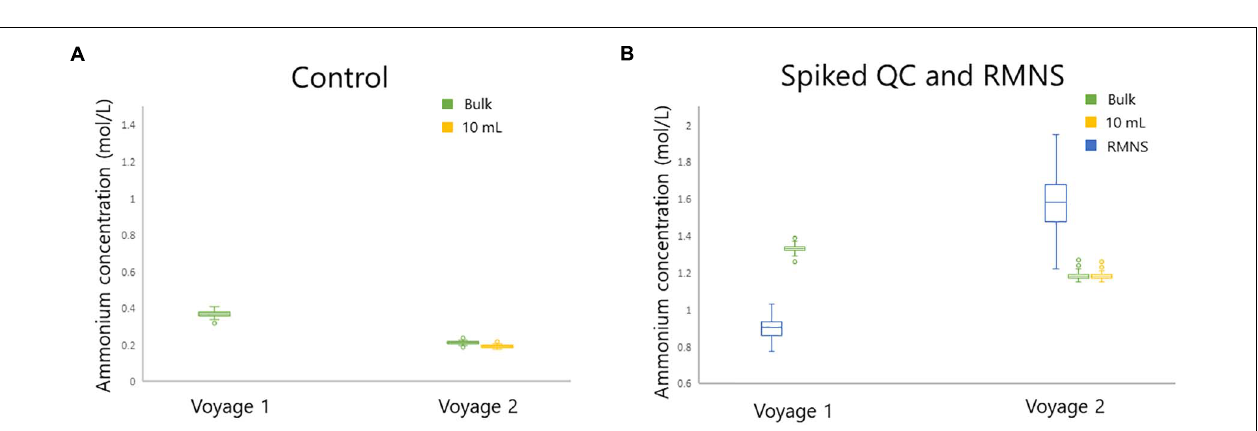
FIGURE 10 | Standard box plot of the ammonium concentration (in µ mol/L) for (A) the Control for bulk (green) and 10 mL (yellow) and (B) RMNS (blue), and the bulk Spiked QC (green), and 10 mL Spiked QC (yellow) during voyage 1 and voyage 2 on board the RV Investigator. Outlier points as shown as